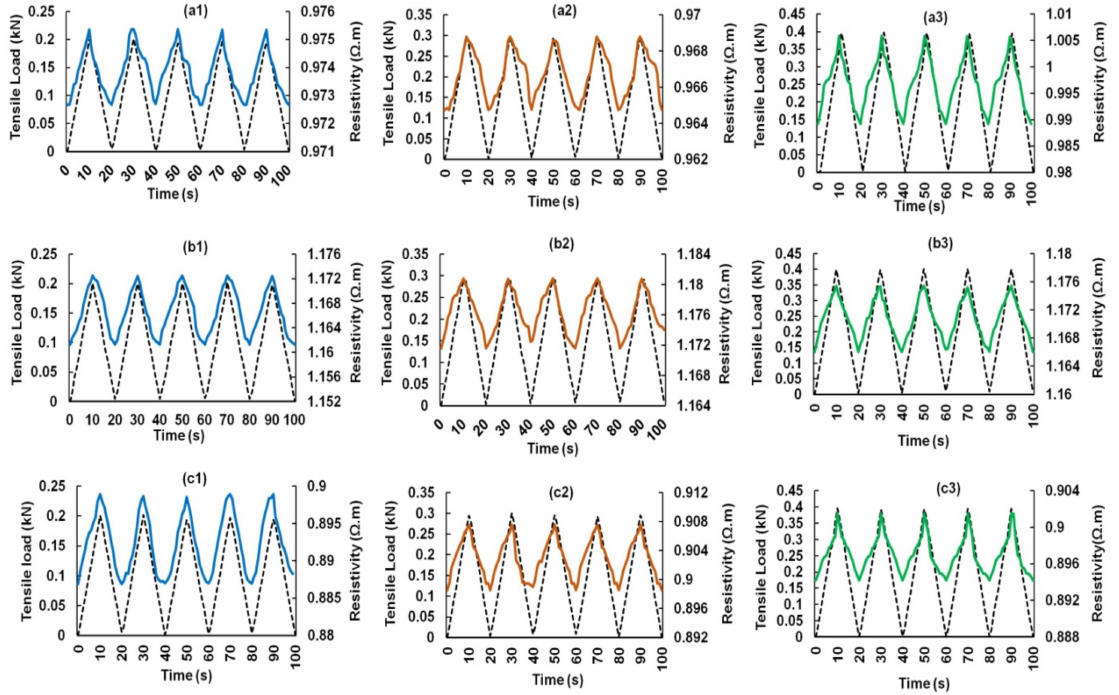
Figure 10. Change of electrical resistance with cyclic tensile load of 0.1% CNF-reinforced cementitious composites at different peak loads containing 0.25% CF ( a1 – a3 ), 0.50% CF ( b1 – b3 ) and 0.75% CF ( c1 – c3